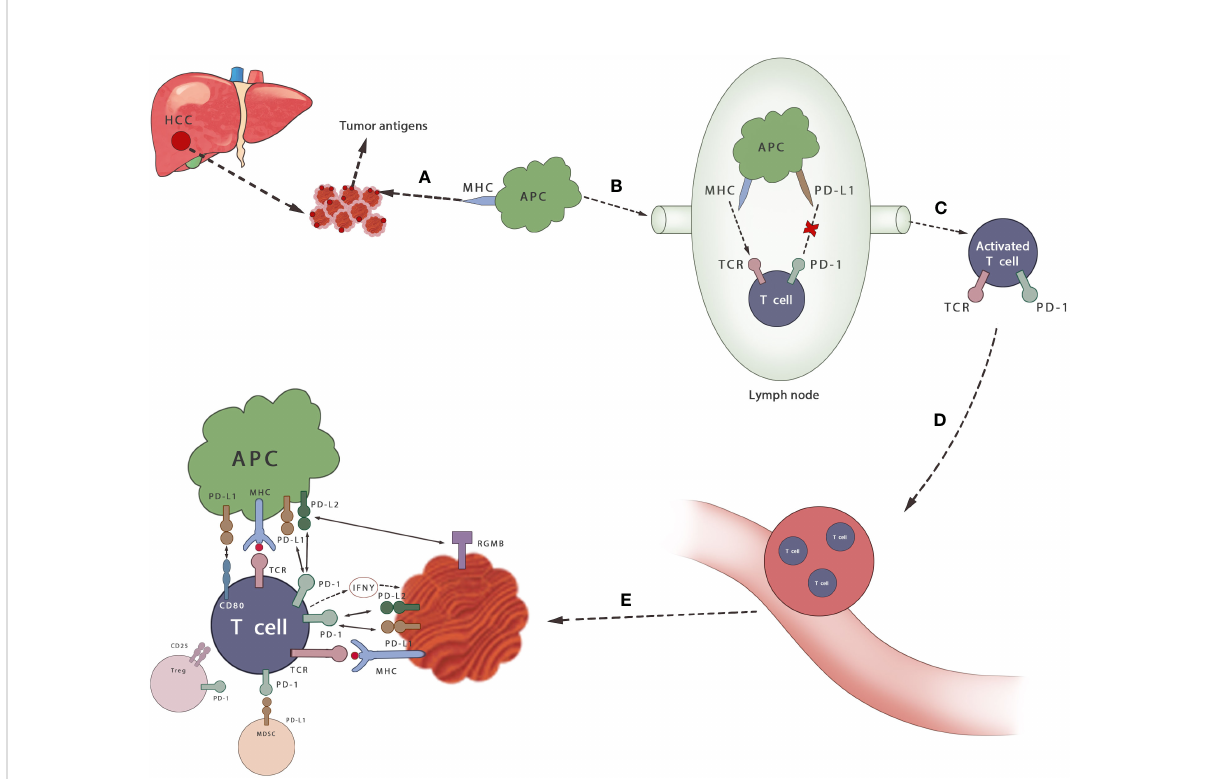
FIGURE 2 Mechanisms of PD-1/PD-L1 axis in HCC. (A) Cancer antigen is released from HCC cells and recognized by APCs (B) APCs that capture antigens migrate to lymph nodes (C) APC presents antigen to immature T cells through TCR and activates T cells, which can be inhibited by PD-1/PD-L1 axis (D, E) T cells in fi ltrate to the tumor. Activated T cells secrete IFN g and stimulate cancer cells to express PD-L1 and protect themselves. By binding its ligand PD-L1 or PD-L2, it can prevent the stimulation signal of TCR, reduce the activity of T cells and prevent autoimmune damage during the immune response. MDSCS inhibits the activation of T cells by binding to PD-1 on T cells. Tregs also inhibits the proliferation and activation of T